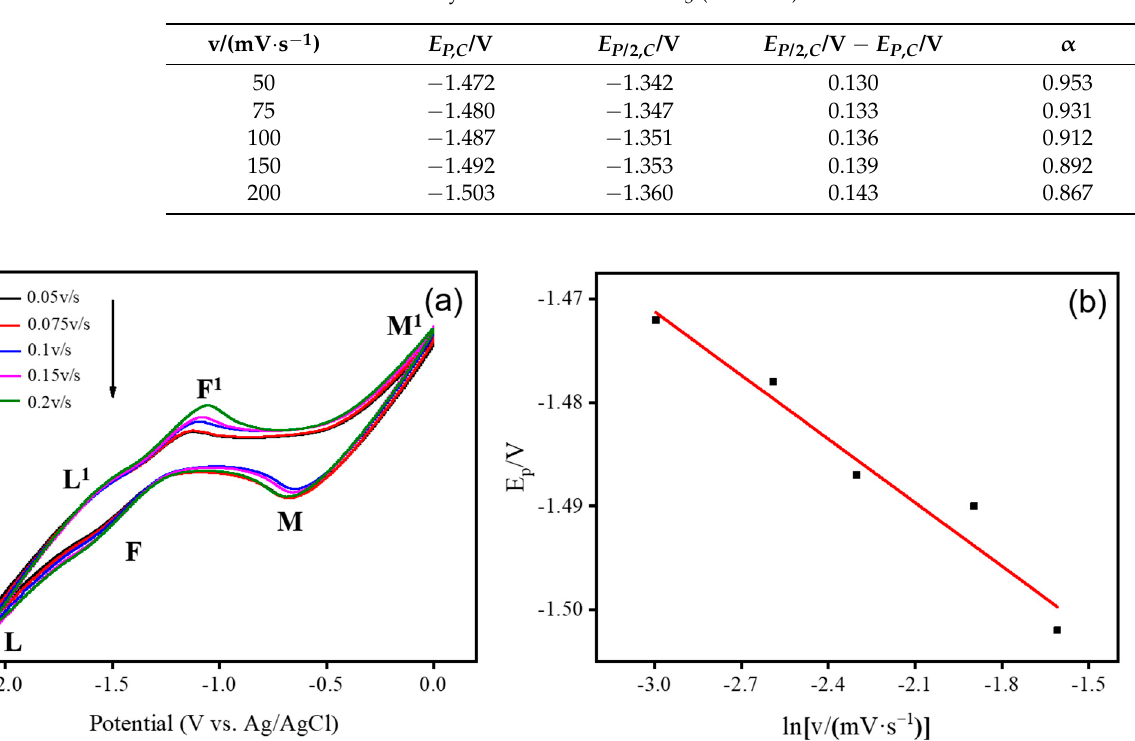
Table 1. Values of peak cathodic potential, half-front potential and α n of Ce 3+ on liquid metal indium electrode in the molten salt system of LiCl-KCl-CeCl 3 (3.0 wt.%) at 773 K.